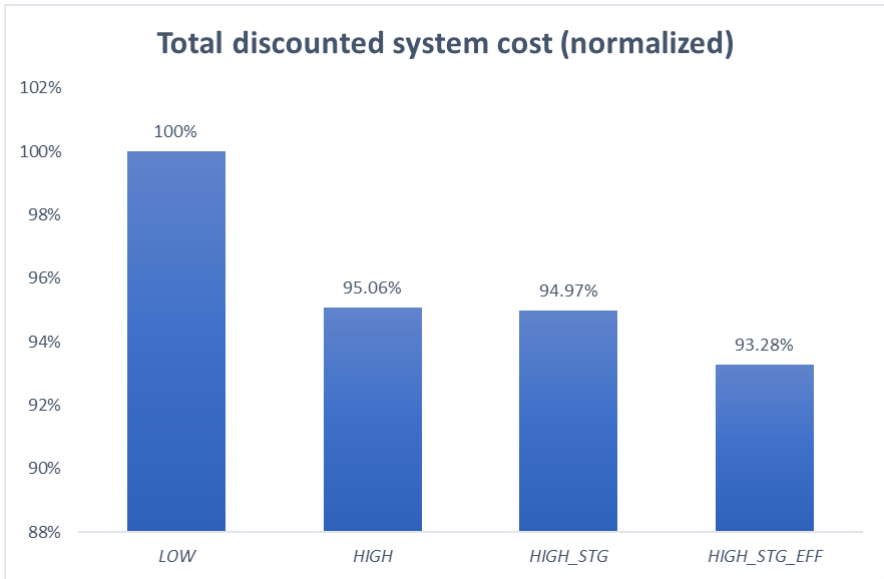
Figure 17. Total discounted system cost normalized with respect to the LOW scenario.